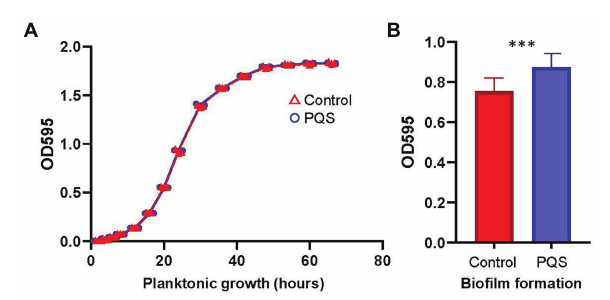
FIGURE 3 | Influence of 10 μ M PQS on planktonic growth and biofilm formation of Erythrobacter sp. HKB8. (A) Planktonic growth and (B) biofilm formation ( *** p <